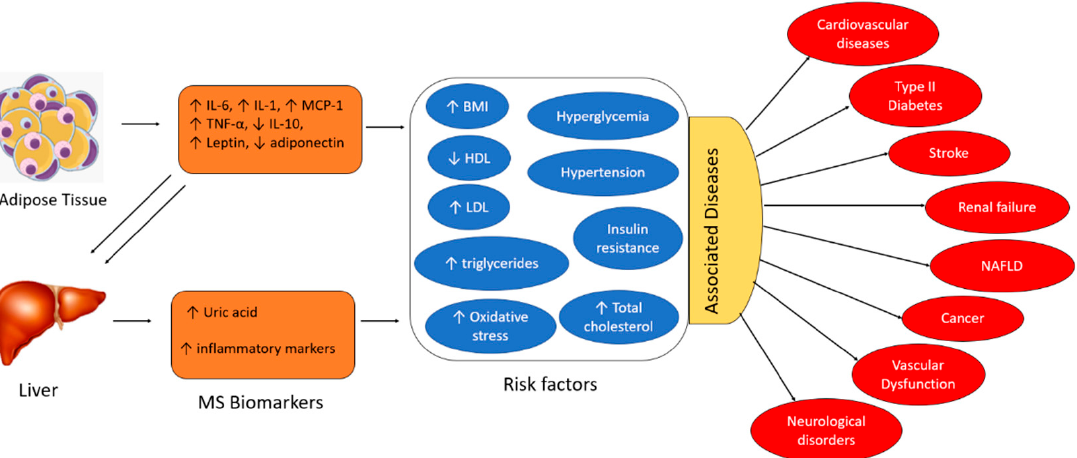
Figure 1. Interaction of adipokines and inflammatory biomarkers that contribute to the development of metabolic syndrome and its associated risk factors and diseases (HDL: high-density lipoprotein, LDL: low-density lipoprotein, NAFLD: non-alcoholic fatty liver disease, BMI: body mass